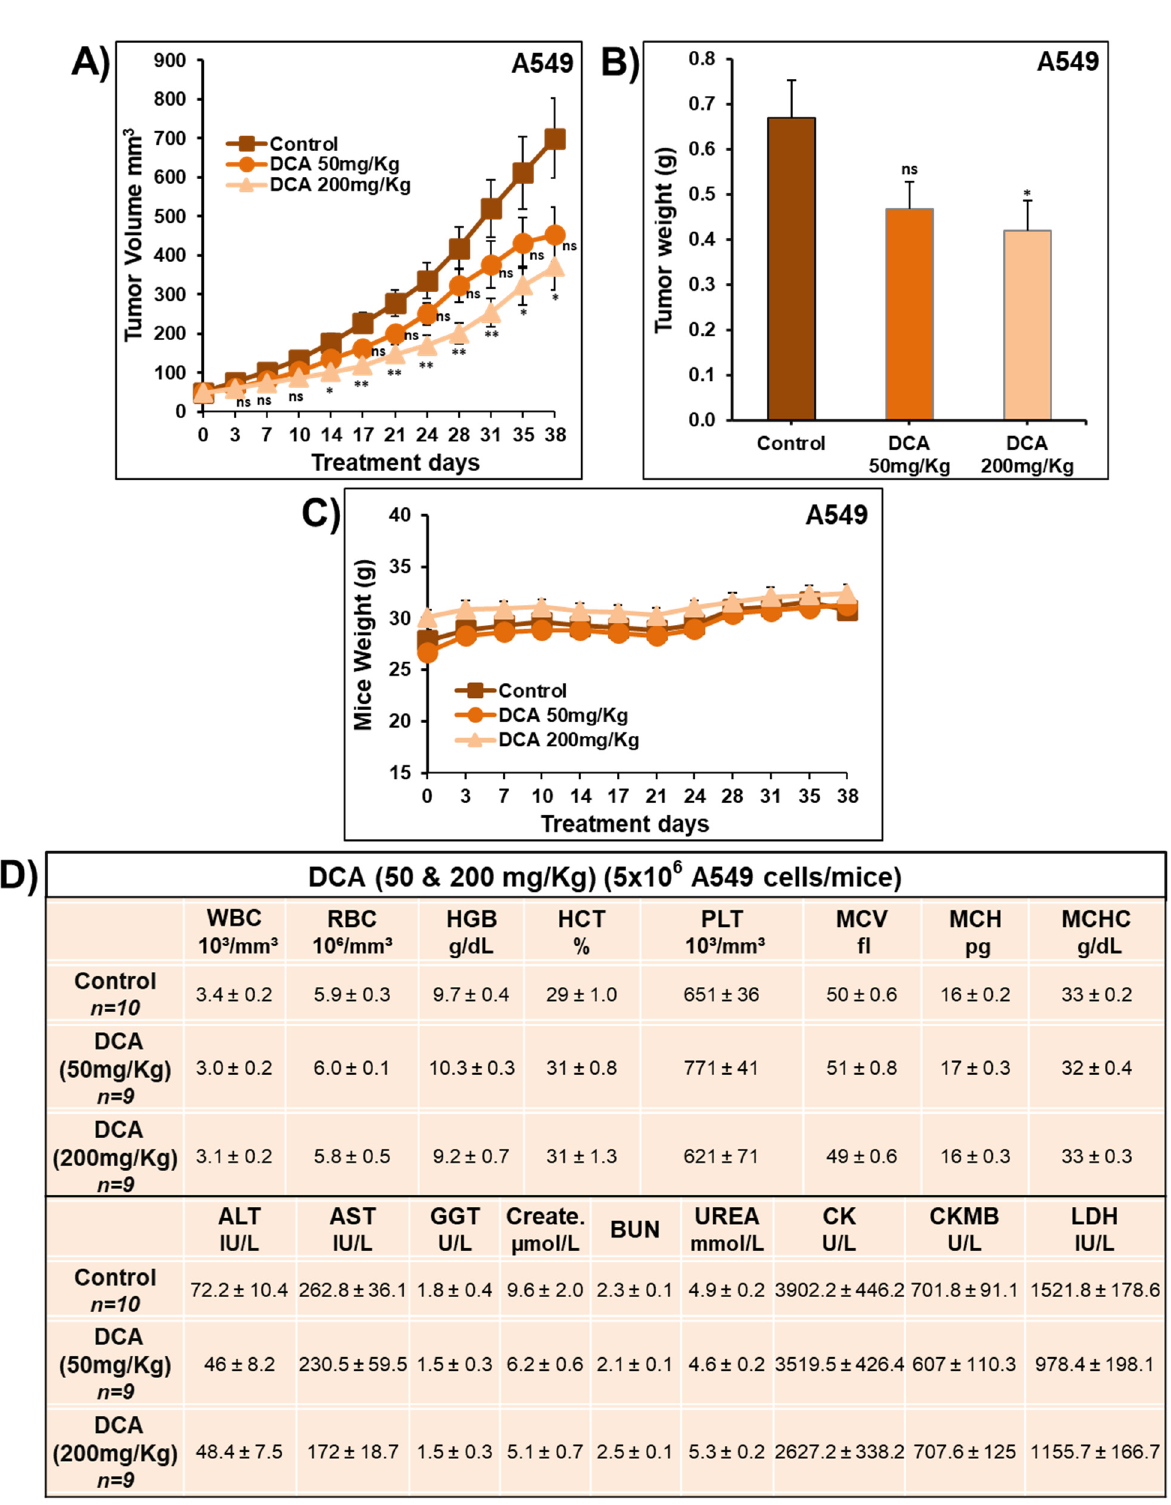
Figure 3. Effect of DCA on the growth of A549 xenografted in nude mice in vivo. ( A ) Tumor volume of A549 xenograft inoculated subcutaneously in nude mice and treated with DCA (50 and 200 mg/kg) orally or control carrier solution alone for a total of 38 days. ( B ) Tumor weight obtained from the same control and DCA-treated nude mice. ( C ) Average of the mice body weight through the treatment days. ( D ) Mice blood samples were analyzed for complete blood count, liver and kidney function parameters. Results represent mean ± S.E.M. of 9–10 mice/group. * Significantly different at <0.05. ** Significantly different at <0.01. ns—non-significant.